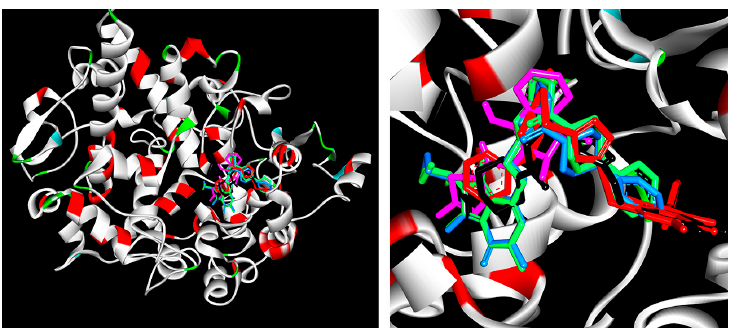
Figure 4. Docking poses of studied compounds 5a , b – 6a , b and Meloxicam (pink) inside COX-2.